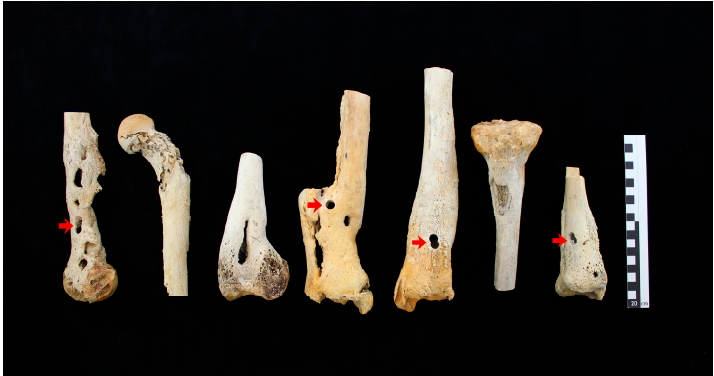
Figure 1. Bone specimens from seven different individuals with apparent signs of an osteomyelitis infestation. From left to right: 13:K:40:4 (femur, distal), 13:K:40:7 (femur, proximal), 13:K:40:9 (femur, distal), 13:K:42:3 (tibia and fibula, distal), 13:K:42:12 (tibia, distal), 13:K:42:14 (tibia, proximal), 13:K:43:1 (tibia, distal). Sampling sites: diaphysis all specimens, four specimens additionally close to the metaphysis (red arrows).